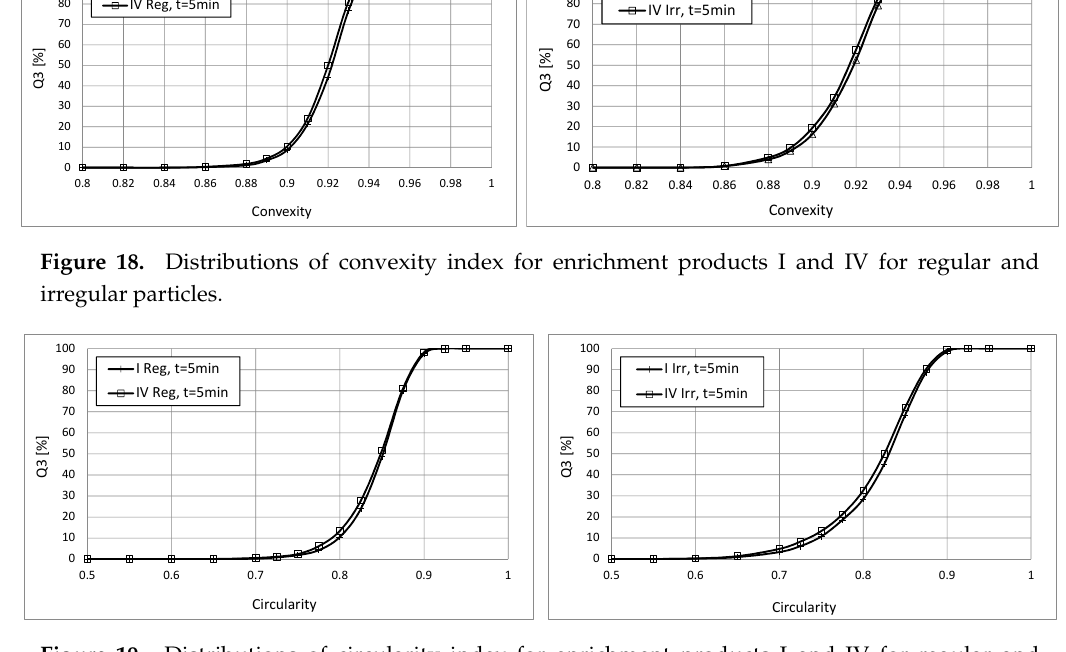
Figure 19. Distributions of circularity index for enrichment products I and IV for regular and irregular particles.